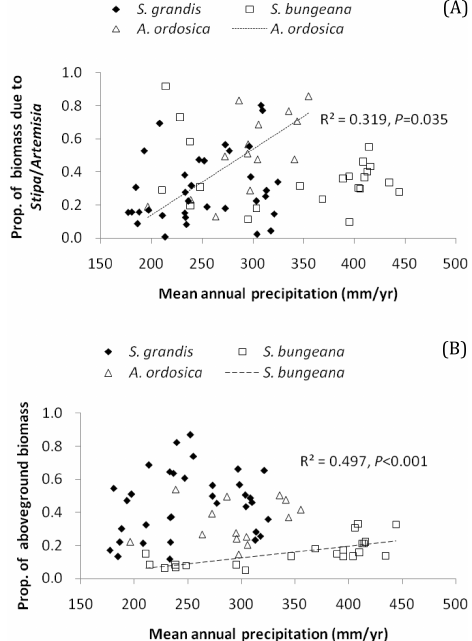
Figure 3. Relationship between percentage of vegetation biomass due to Stipa / Artemisia and mean annual precipitation (a) , percent- age of biomass aboveground in Stipa / Artemisia and mean annual precipitation (b) , both along the two